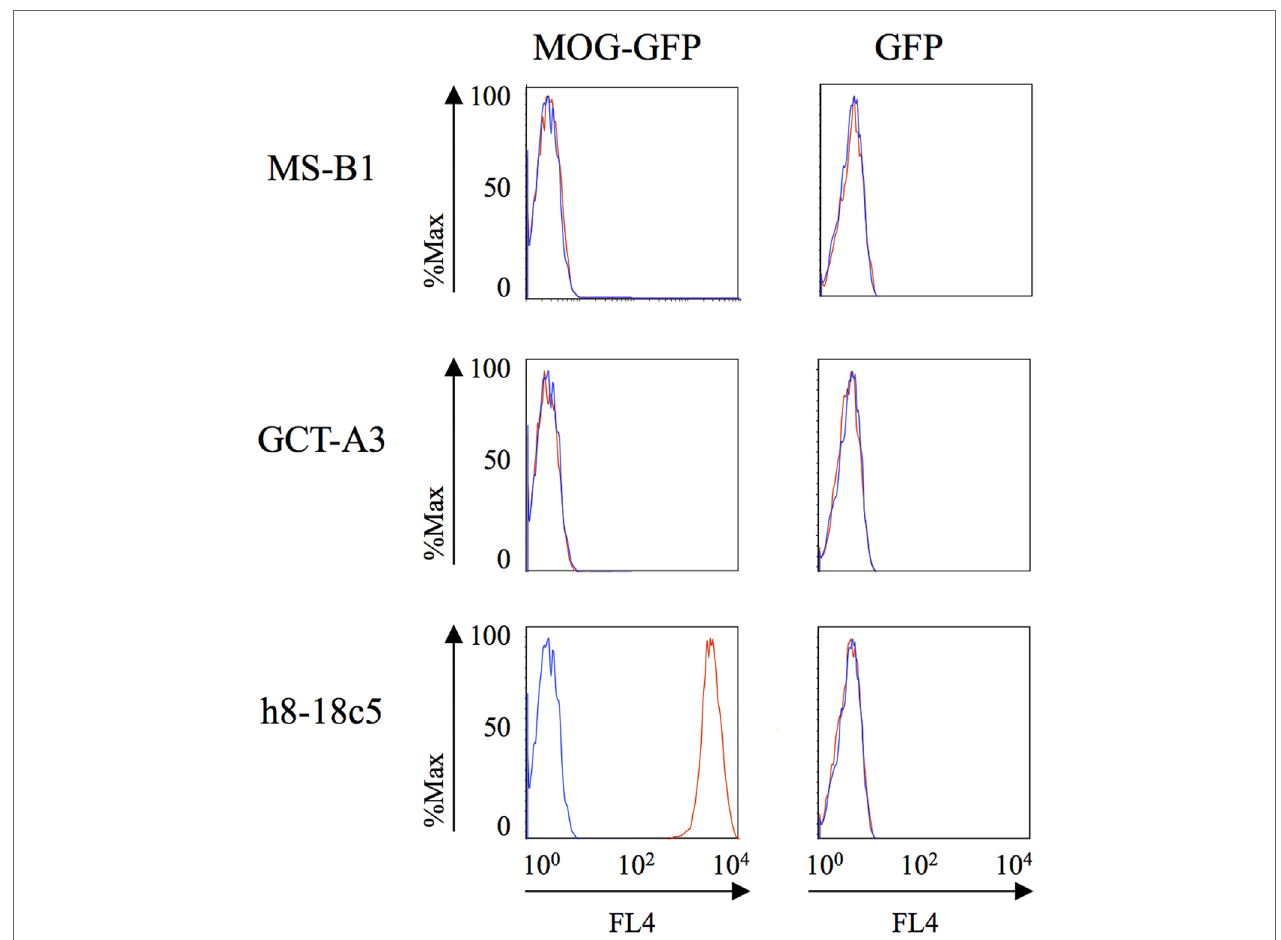
FigUre 2 | Ms and control-derived rigg binding to MOg detected with a cell-based assay . Representative binding of MS (MS-B1) or germinoma control-derived (GCT-A3) rIgG to Jurkat cells transfected with MOG-GFP (left column) or GFP alone (right column). Histograms show the MFI of transfected cells gated on those that were positive for both GFP and a florescent anti-human secondary antibody (red). The blue histograms show secondary antibody alone. A humanized monoclonal antibody, h8-18c5, specific for human MOG served as a positive control for the Jurkat–MOG–GFP binding. FACS data for additional rIgGs from the MS and control groups are shown in the Supplementary